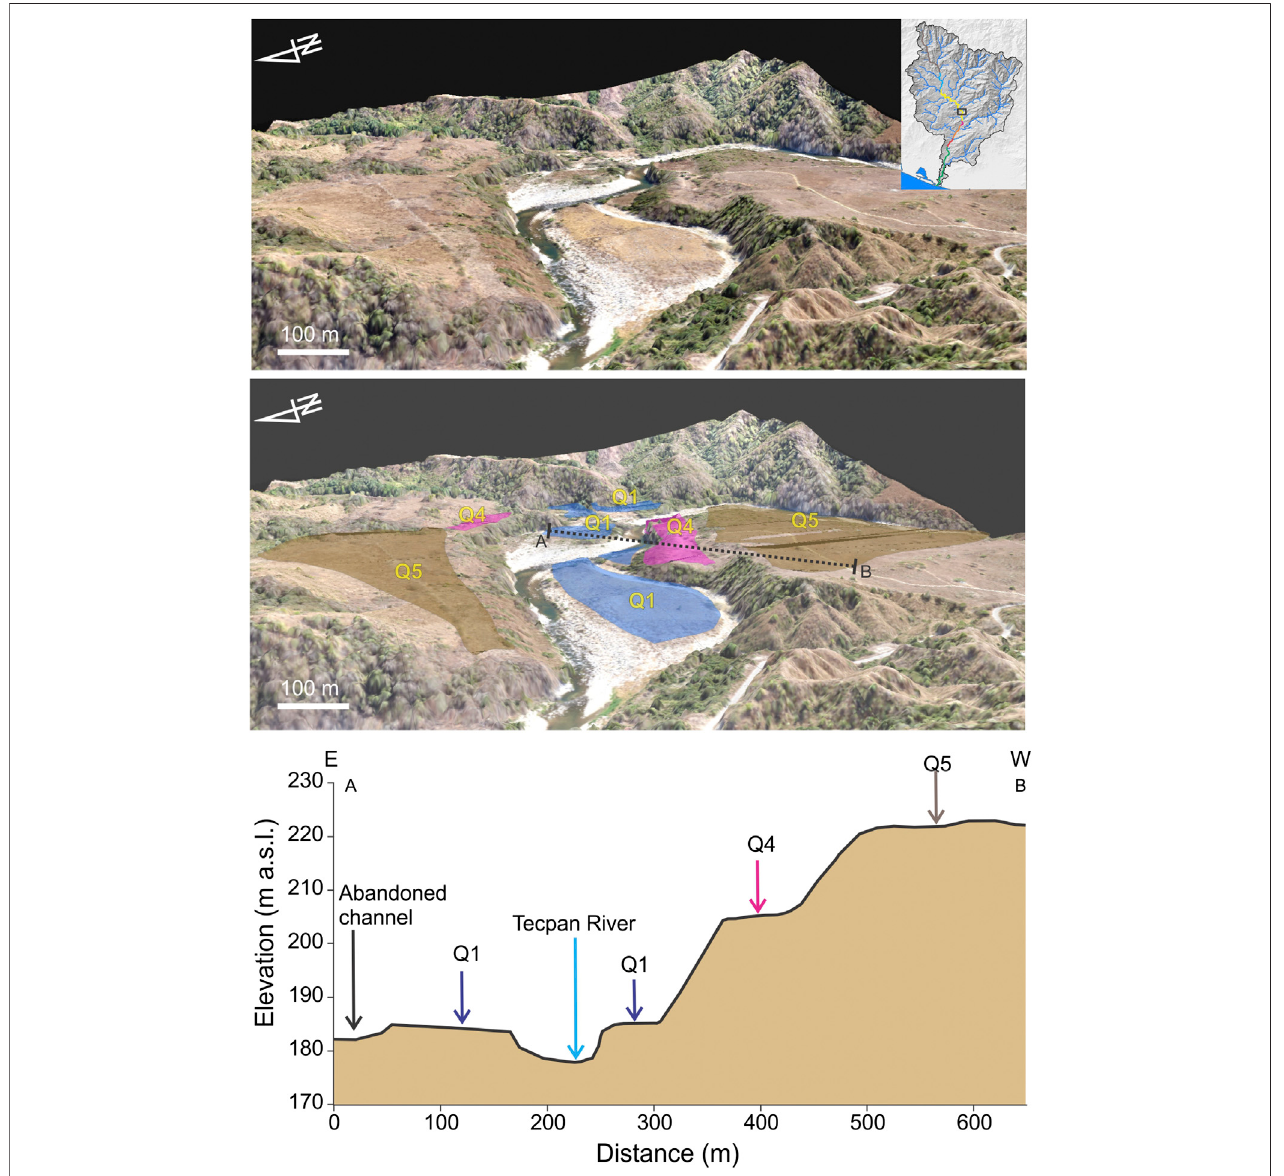
FIGURE 6 | Photographs and stratigraphy pro fi les of sampled terraces along the Tecpan River.